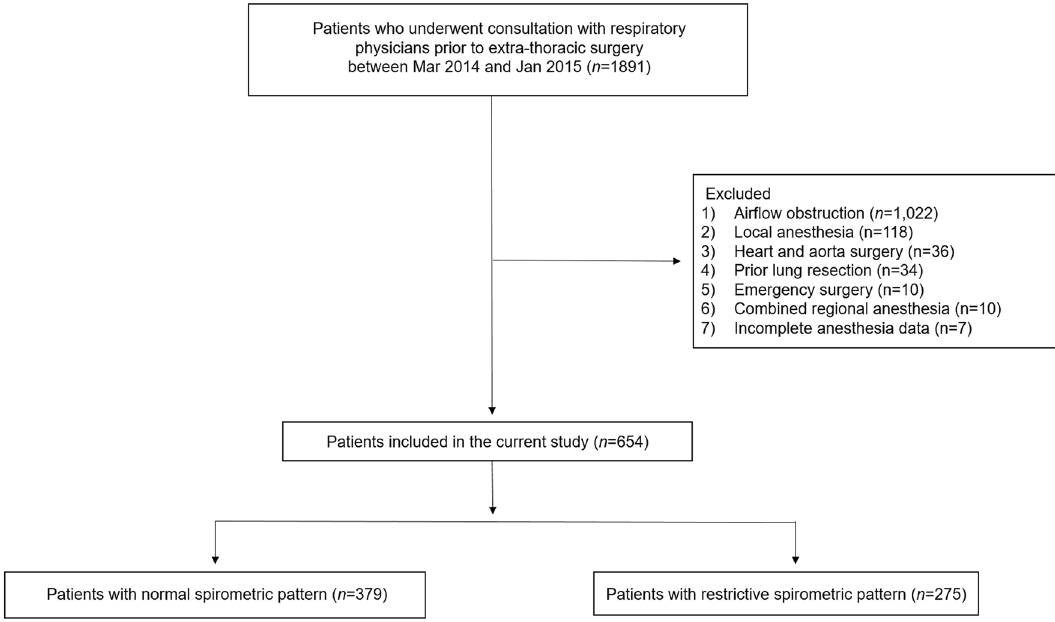
Figure 1. Consolidated standards of reporting trials